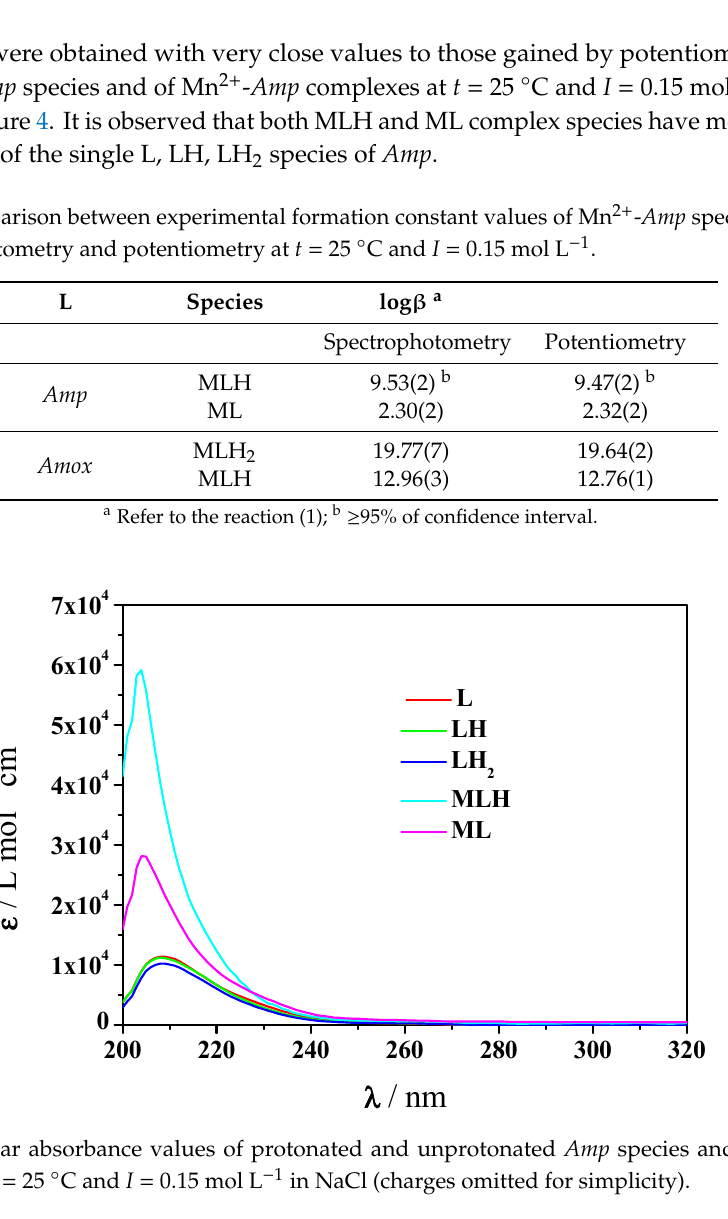
Figure 4. Molar absorbance values of protonated and unprotonated Amp species and Mn 2+ - Amp complexes at t = 25 °C and I = 0.15 mol L − 1 in NaCl (charges omitted for